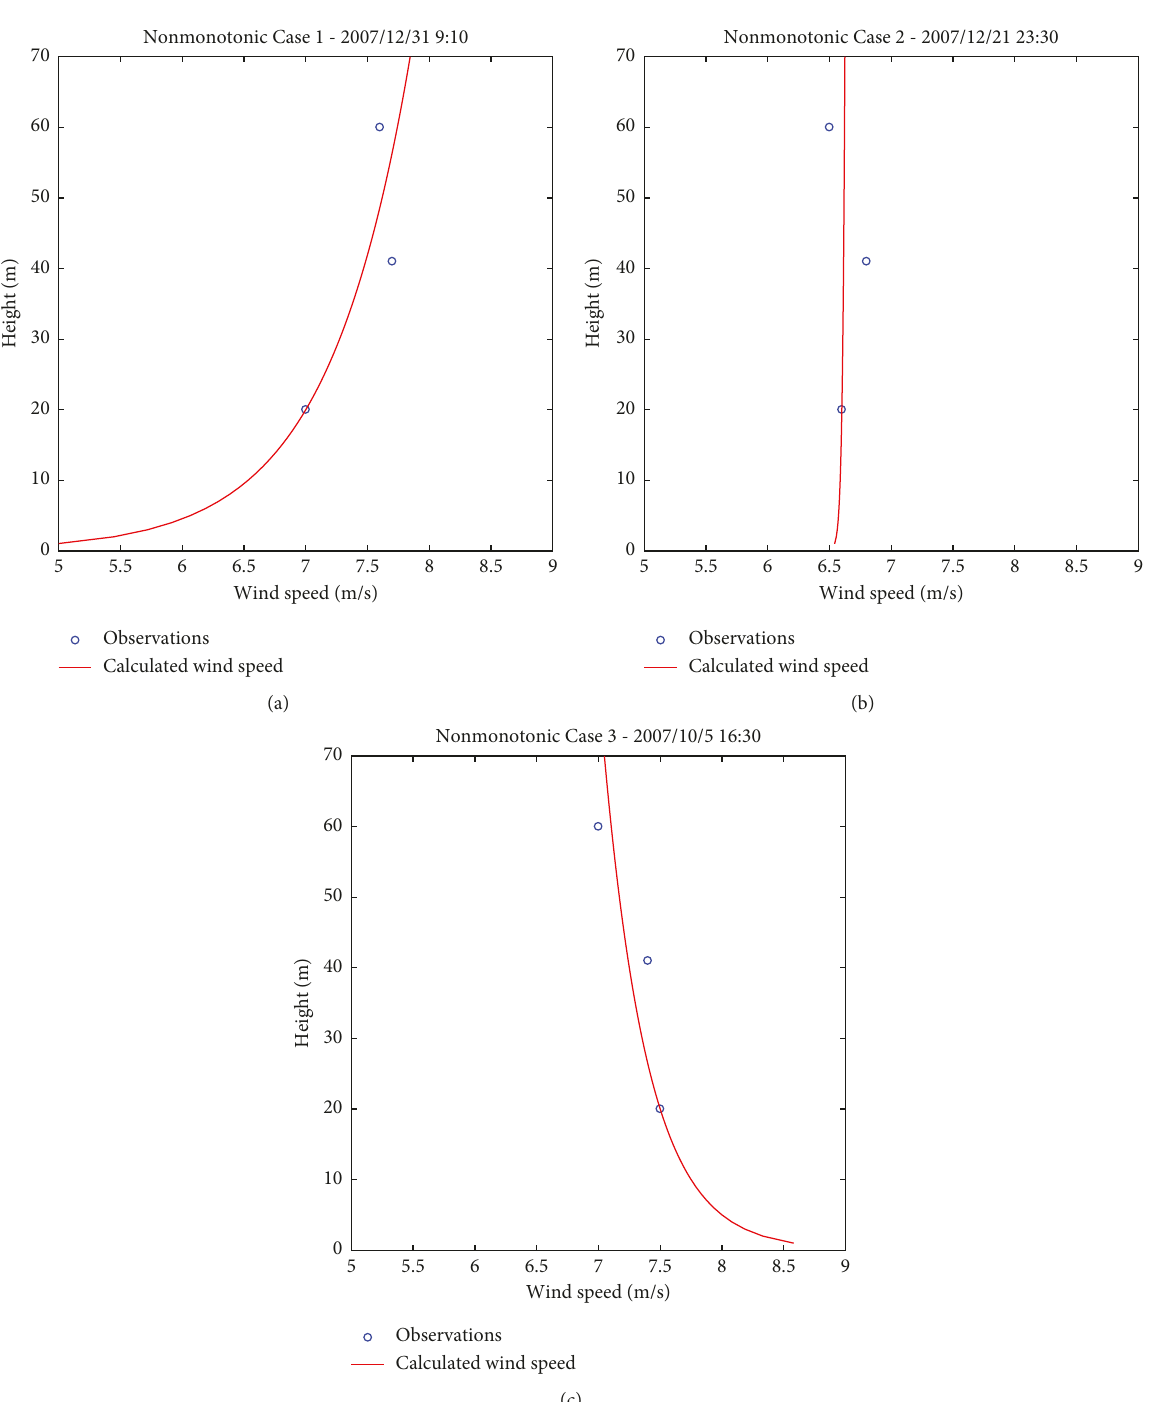
Figure 5: Examples of three types of observed, nonmonotonic wind speed profiles from the CW Historical data set and resulting log-fits using the statistical method: (a) Case 1 (zig-zag with positive wind shear and realistic z 0 ); (b) Case 2 (shearless with very low z 0 ); and (c) Case 3 (negative wind shear and very large z 0 ). The intercept of the log-fit (red line) and the y -axis represents the z 0 value in each